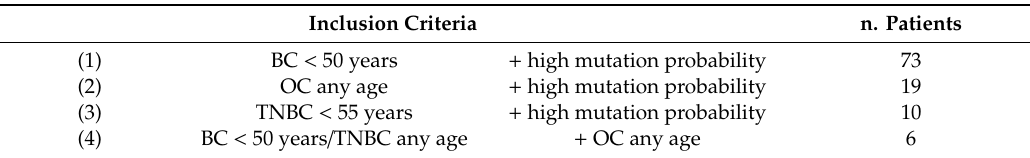
Table 1. Study cohort composition following the reported inclusion criteria. BC, breast cancer; OC, ovarian cancer; TNBC, triple negative breast